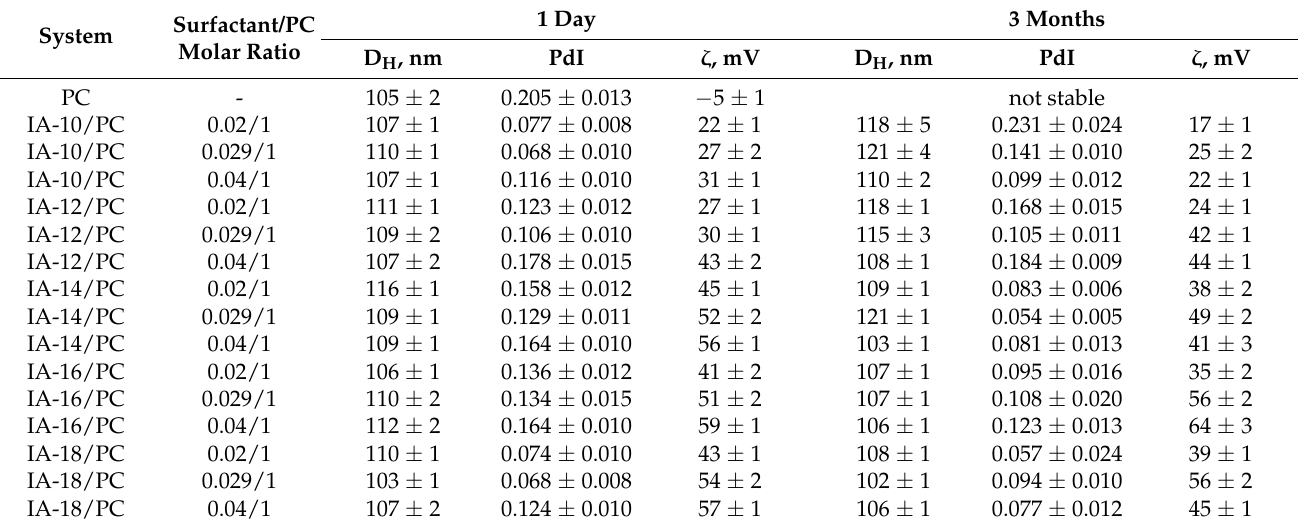
Table 1. Physicochemical characteristics of liposomes based on PC modified by IA-n at various surfactant/lipid molar ratios, hydrocarbon tail length, and storage times: hydrodynamic diameter (D H , nm), polydispersity index (PdI), and zeta potential ( ζ , mV), 25 ◦ C.